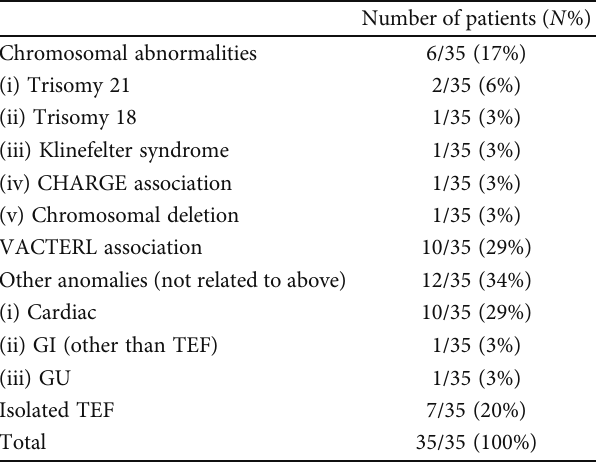
Table 2: Associated congenital anomalies.